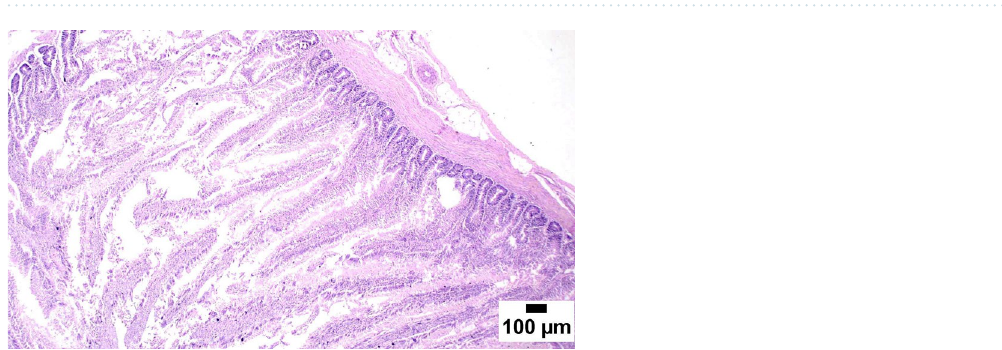
Figure 3. Photomicrograph of the duodenum, B group at 35 days showing atrophied intestinal villi